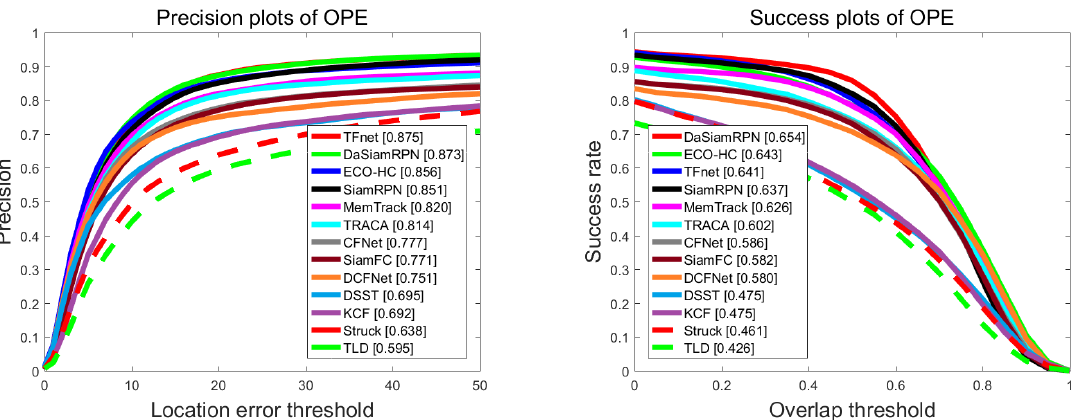
Figure 5. Distance precision plot and overlap success rates plot using one-pass evaluation on the OTB2015